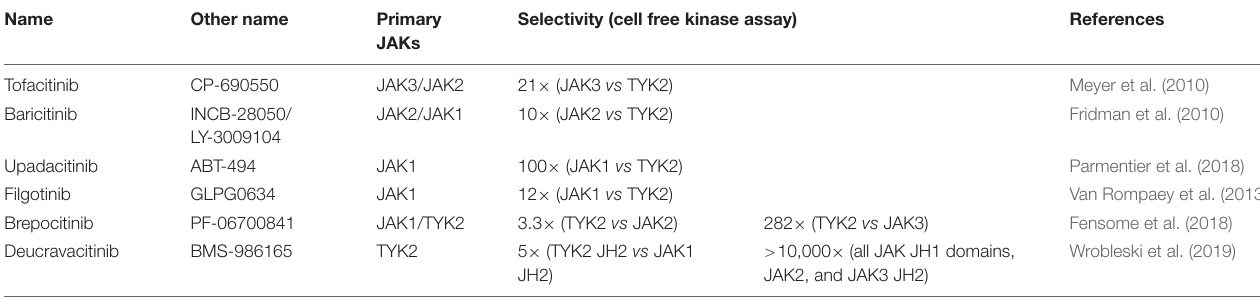
TABLE 2 | Janus kinase (JAK) inhibitors and their specificity for